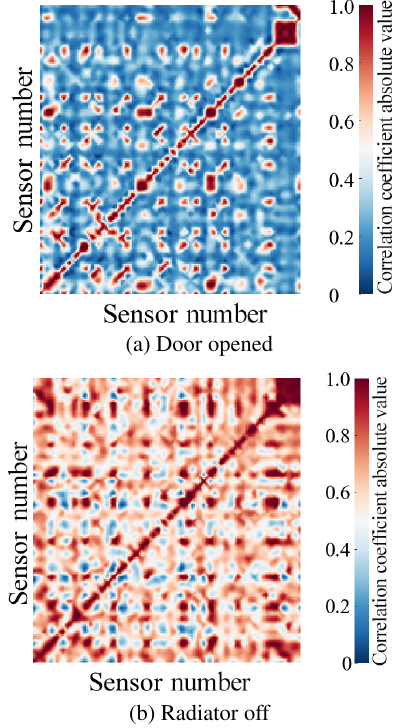
Fig. 7 Correlation heat-maps between sensors.